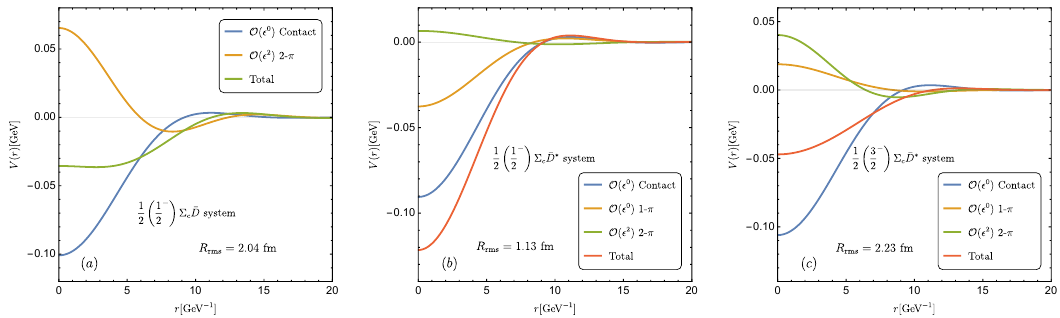
Figure 9 . The e(cid:11)ective potentials of the (cid:6) c (cid:22) D ( (cid:3) ) systems. Their I ( J P ) are marked in each sub(cid:12)gure. The potentials are obtained with the cuto(cid:11) parameter (cid:3) = 0 : 5 GeV, and the LECs D 1 = 52 GeV (cid:0) 2 , D 2 = (cid:0) 4 GeV (cid:0) 2 . The R rms in each sub(cid:12)gure denotes the root-mean-square radius of the corresponding